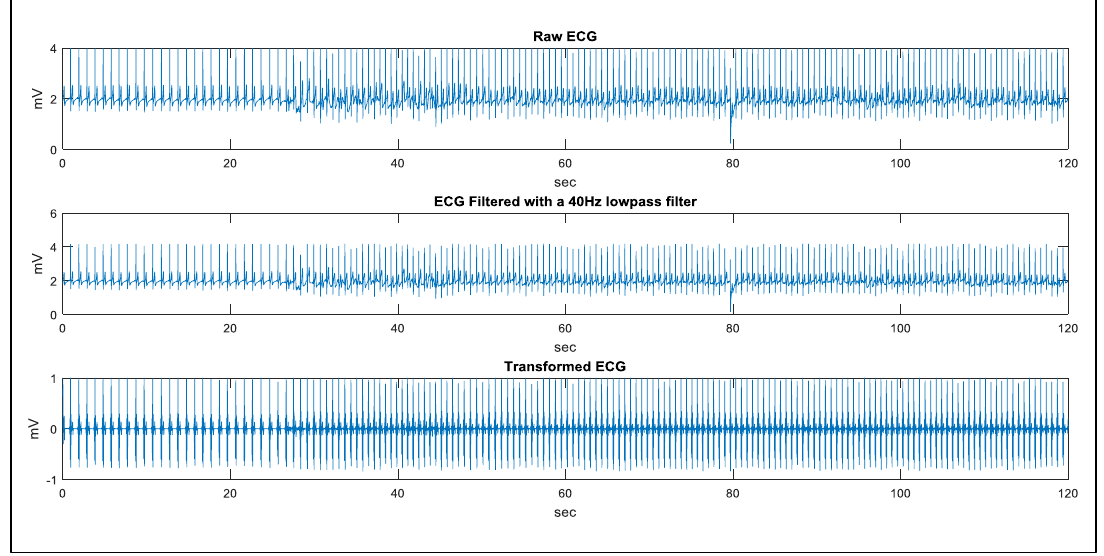
Figure 18. The algorithm implementation in a wearable heart rate sensor. Sensors 2017 , 17 , 1969